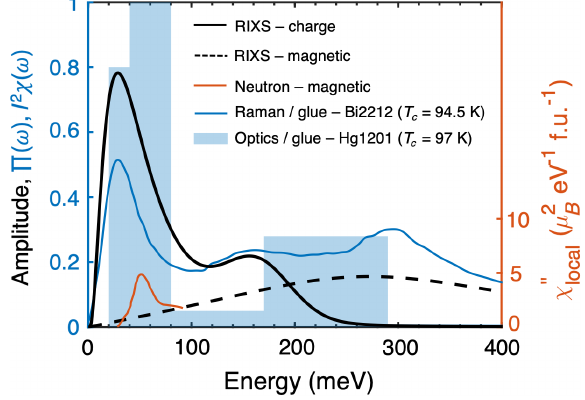
FIG. 6. Comparison of RIXS results for dynamic charge and paramagnon response in Hg1201 with estimates for the super- conducting pairing glue. The black solid and dashed lines are the amplitudes of the charge and magnetic excitations in Hg1201 at ¼ 70 K from the present work. As discussed in the text, T ¼ T c the charge signal is multiplied by a factor of 10. The red solid line indicates the local magnetic susceptibility of Hg1201 measured by neutron scattering at the nearly same doping level [53]. The blue shaded area is the bosonic glue function extracted from ¼ 97 K) optical measurements of optimally doped Hg1201 ( T c at 100 K [63]; in this work, the glue function was not extracted for underdoped Hg1201, but it was established from analysis of other cuprates that the two characteristic energy scales are rather robust in the relevant doping range. The solid blue line is a glue function estimate for Bi2212 from Raman spectroscopy [64], again at optimal doping; results in B 1 and B 2 symmetry are weighted g g 2 ∶ 1 to best highlight the close correspondence of the energy scales with the RIXS